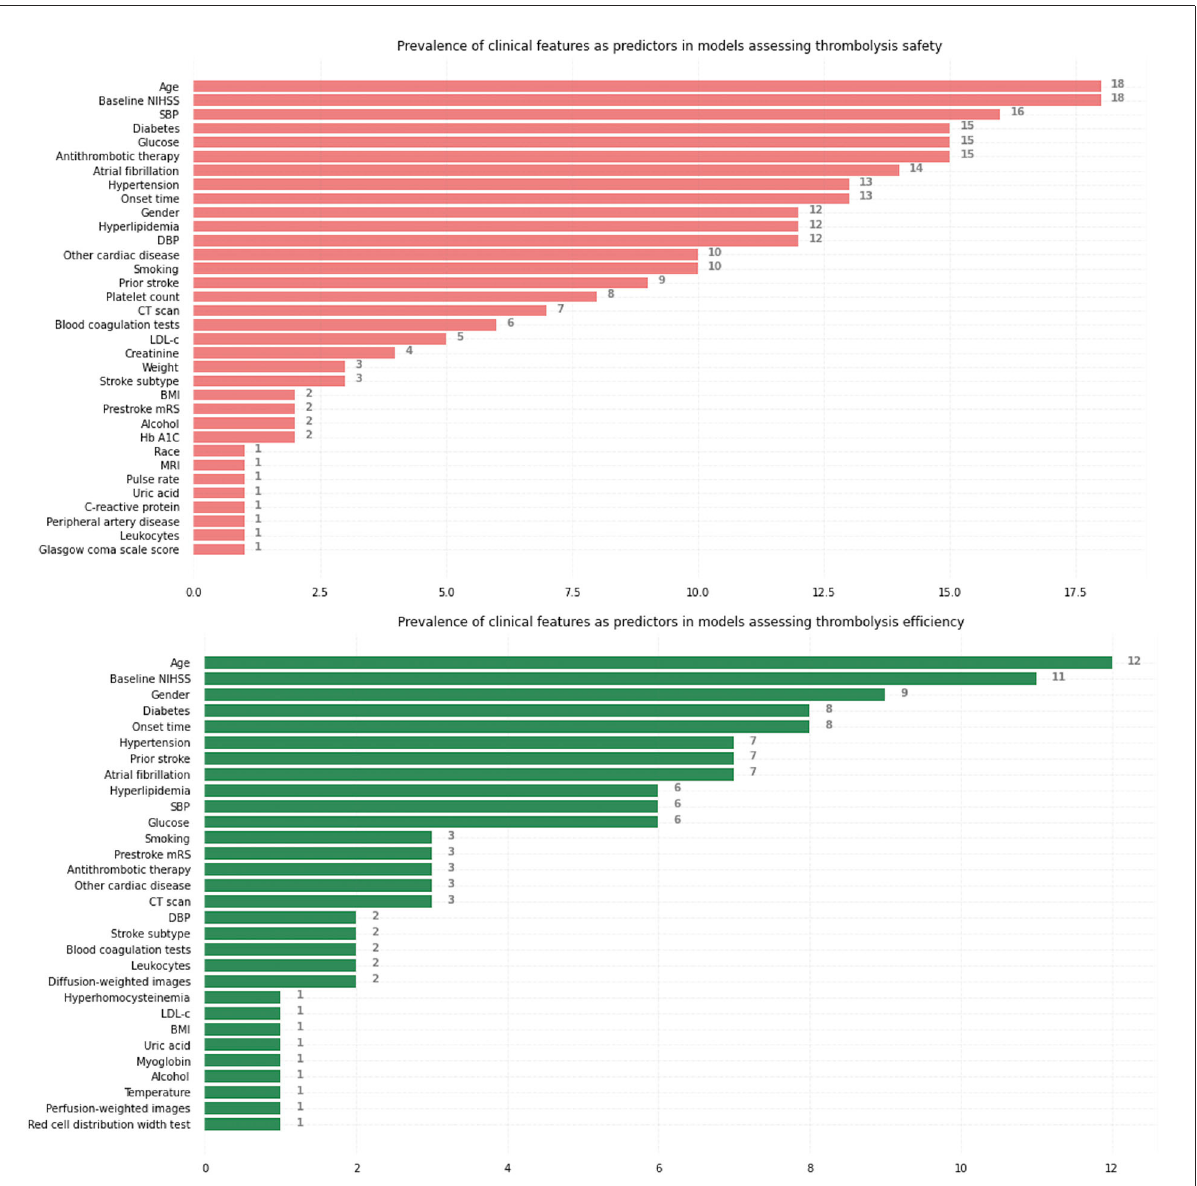
FIGURE3 Prevalence of initially selected clinical features identified by neurologists with clinical expertise or based on related studies as predictors, respectively, in models assessing thrombolysis safety and thrombolysis efficiency. NIHSS, National Institutes of Health Stroke Scale; SBP, systolic blood pressure; DBP, diastolic blood pressure; CT, computed tomography; LDL-c, Low-density-lipoprotein cholesterol; BMI, body mass index; Hb A1C, hemoglobin A1c; MRI, magnetic resonance imaging; mRS, modified Rankin